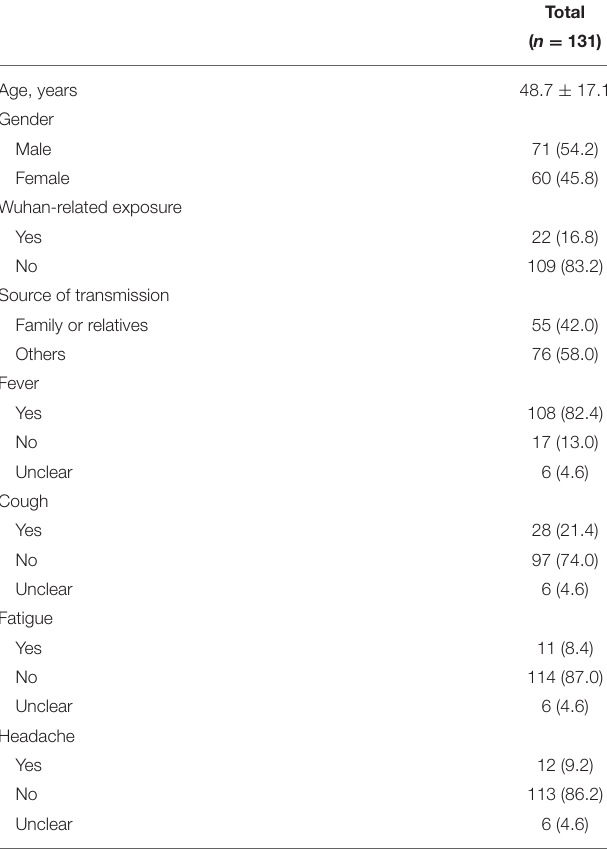
TABLE 1 | Characteristics of 131 confirmed cases with COVID-19 in Tianjin. TABLE 2 | Characteristic of patients with COVID-19 stratified by disease severity.